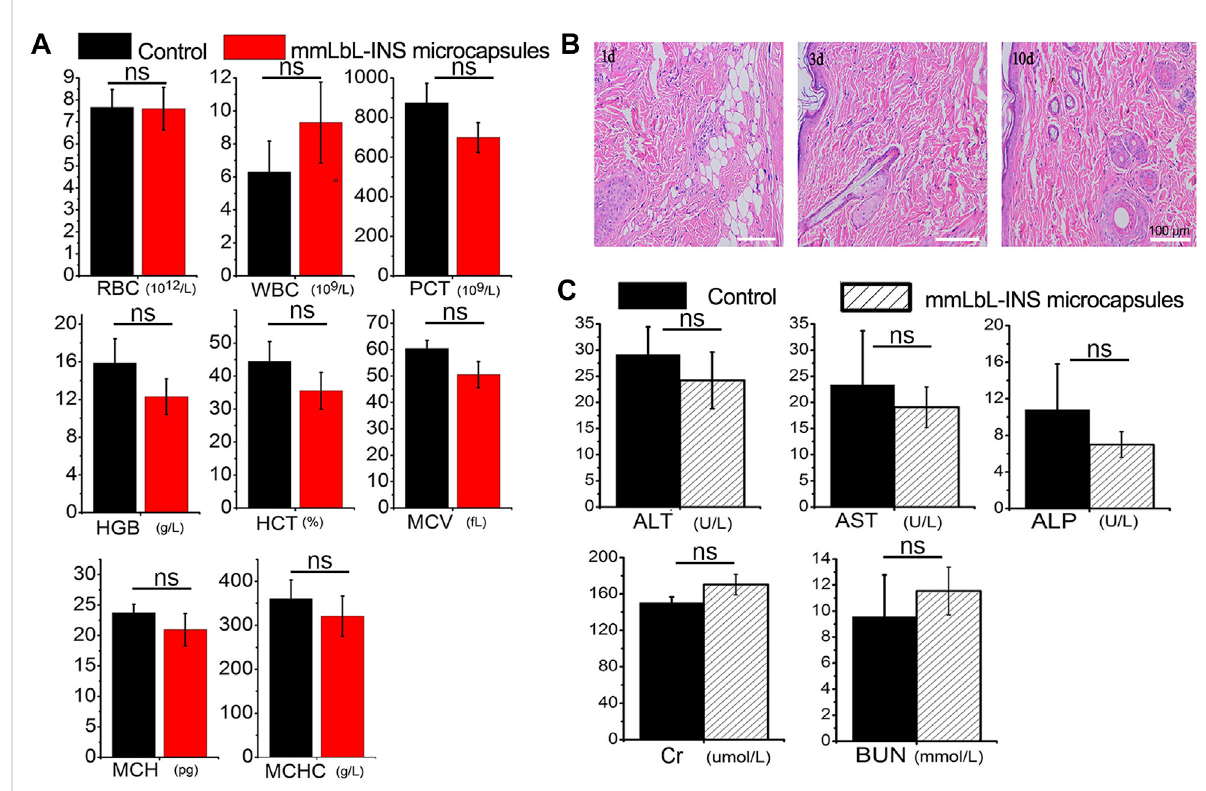
FIGURE 6 Biosafety of the mmLbL-INS microspheres. (A) Hematological parameters after administration of mmLbL-INS microcapsules for 3 days. Red blood cell (RBC), white blood cell (WBC), platelet count (PCT), hemoglobin (HGB), hematocrit (HCT), mean corpuscular volume (MCV), mean corpuscular hemoglobin (MCH), and mean corpuscular hemoglobin concentration (MCHC) were chosen. (B) H&E staining of the injected set. Bar = 100 μ m. (C) Results of liver function markers, including alkaline phosphatase (ALP), alanine aminotransferase (ALT), and aspartate aminotransferase (AST), the kidney function marker urea nitrogen (BUN), and creatinine (Cr). Ns = not statistically different. (n =